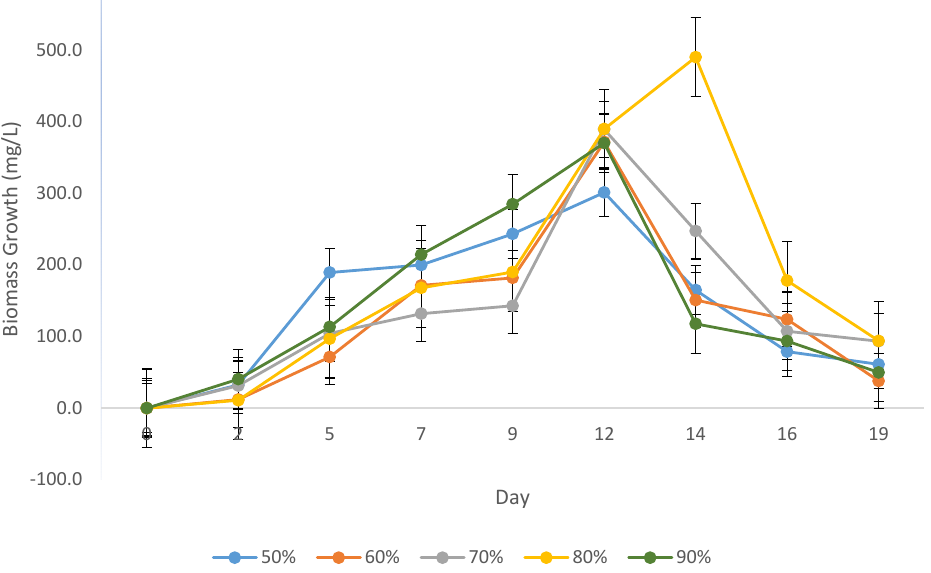
Figure 7. The effect of wastewater mixing ratio on biomass Figure 7. The e ff ect of wastewater mixing ratio on biomass growth.